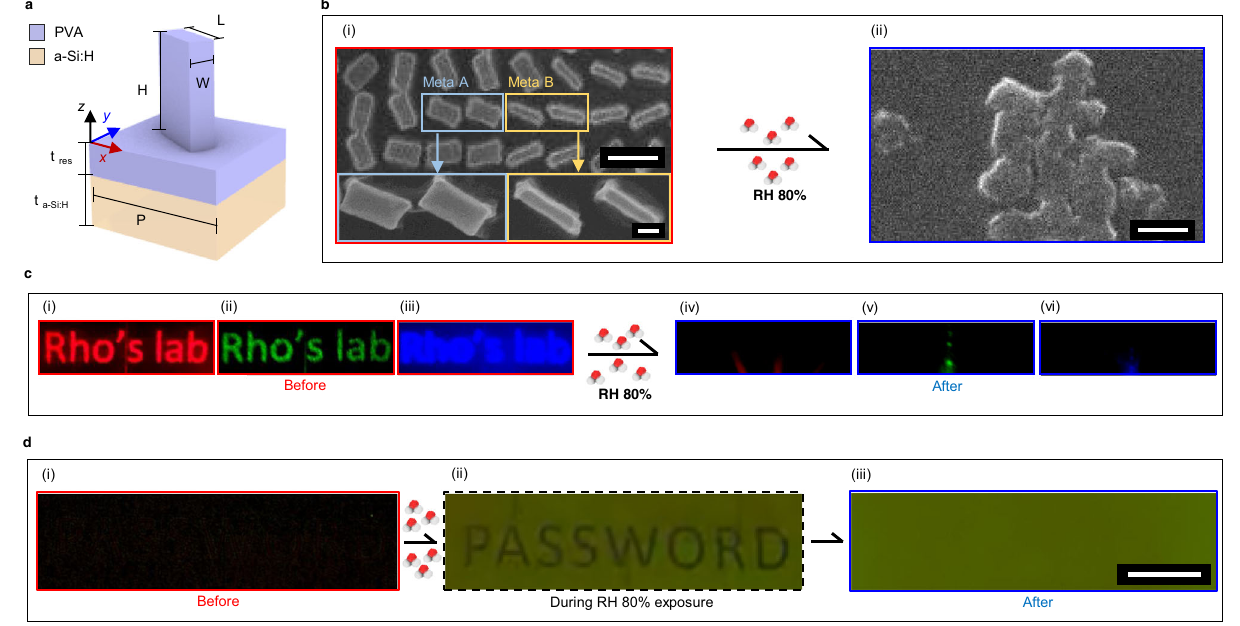
Fig.4|Irreversiblepolyvinylalcoholmetasurfacesforasingle-usetwo-channel securityplatform.a Schematicillustrationofapolyvinylalcohol(PVA)meta-atom on top of hydrogenated amorphous silicon (a-Si:H). b Scanning electron micro- scope (SEM) images of the PVA metasurface (i) before and (ii) after exposure to relative humidity (RH) 80% conditions. Meta A and Meta B are reproduced with high fi delity using nanoimprint lithography (NIL). Scale bars: (i) Top: 500nm, Bottom: 100nm, and (ii) 500nm. c Photographs of the holographic images